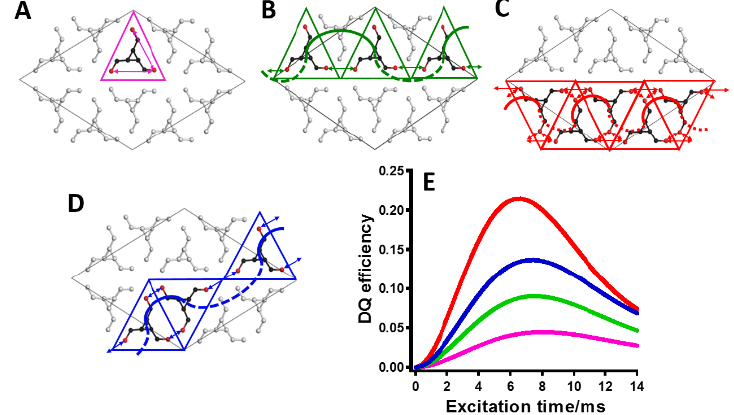
Figure 3. Four chain-folding (CF) patterns of ( A ) CF0, ( B ) CFI, ( C ) CFII, and ( D ) CFIII, and ( E ) the corresponding calculated DQ buildup curves for 35% 13 C CH 3 enriched i PB1 form I crystal blends with non-labeled i PB1 at a blending ratio of 1:9 under the assumption of infinite folding structures [52,55,56]. (Reprinted with permission from ACS Macro Lett . 2016 , 5 , 355 – 358. Copyright (2016) American Chemical Society).